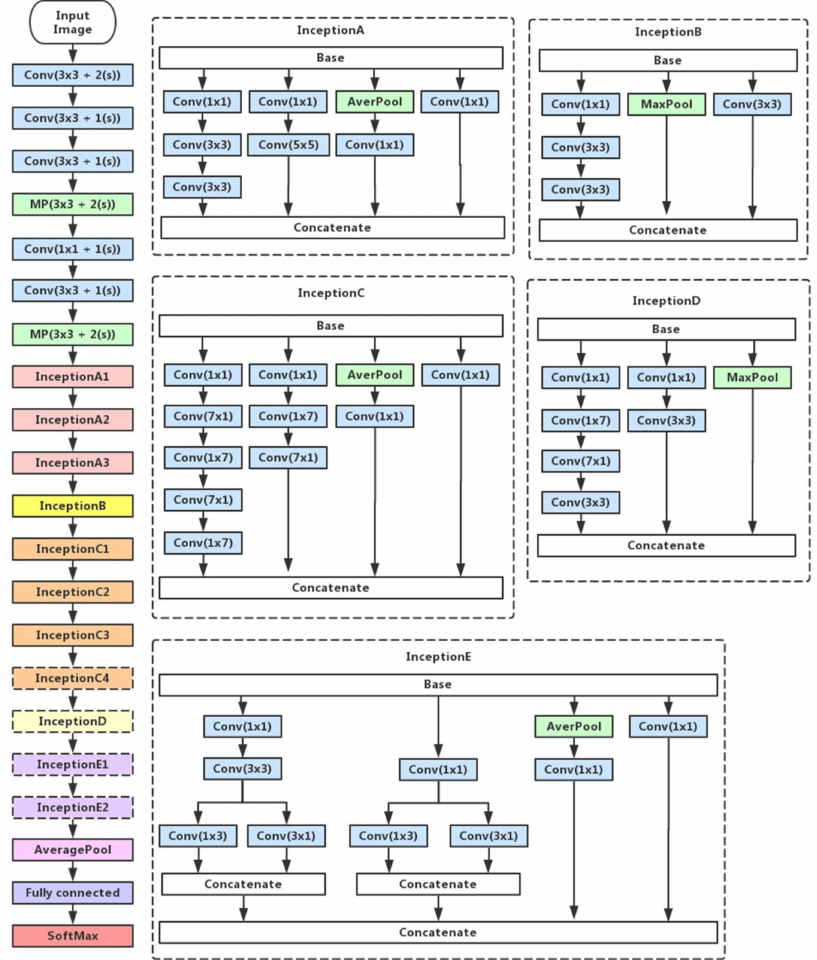
Figure 2. ( Left ) Inception-v3 architecture. Blocks with dotted line represents modules that might be removed in our experiments. ( Right ) Different Inception modules. Inception A, C, E are three kinds of factorization modules. Inception B, D are modules which achieve efficient grid size